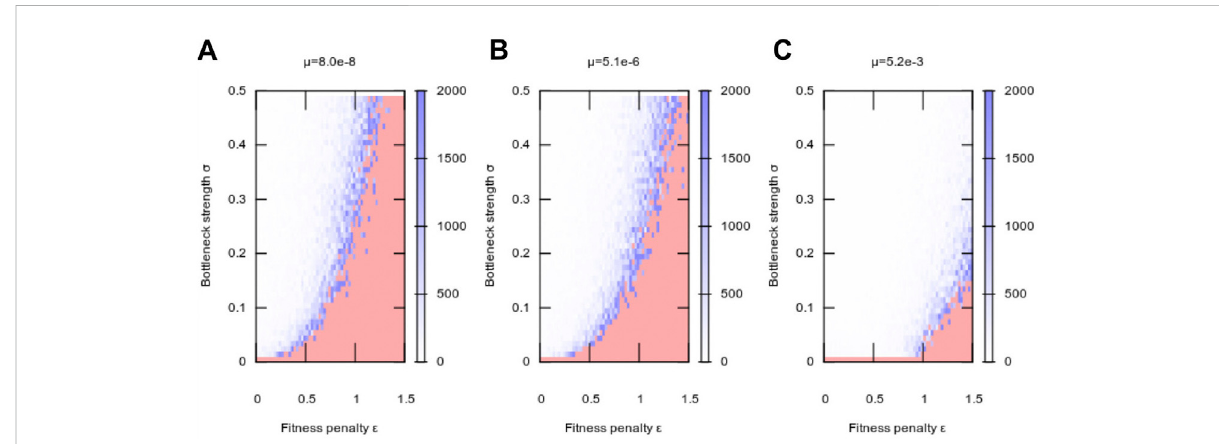
FIGURE 3 Adaptation to a new environment as a function of segregation strength. Plots show, as in Figure 1, the mean number of generations taken for a population to adapt following a change of environment, at (A) low, (B) intermediate, and (C) high mutation rate. Increasing segregation strength σ facilitates adaptation at higher fi tness penalties, with higher mutation rates μ amplifying this effect. At μ = 0, no adaptation was observed in our simulations. Each pixel value is the average over 10 simulation